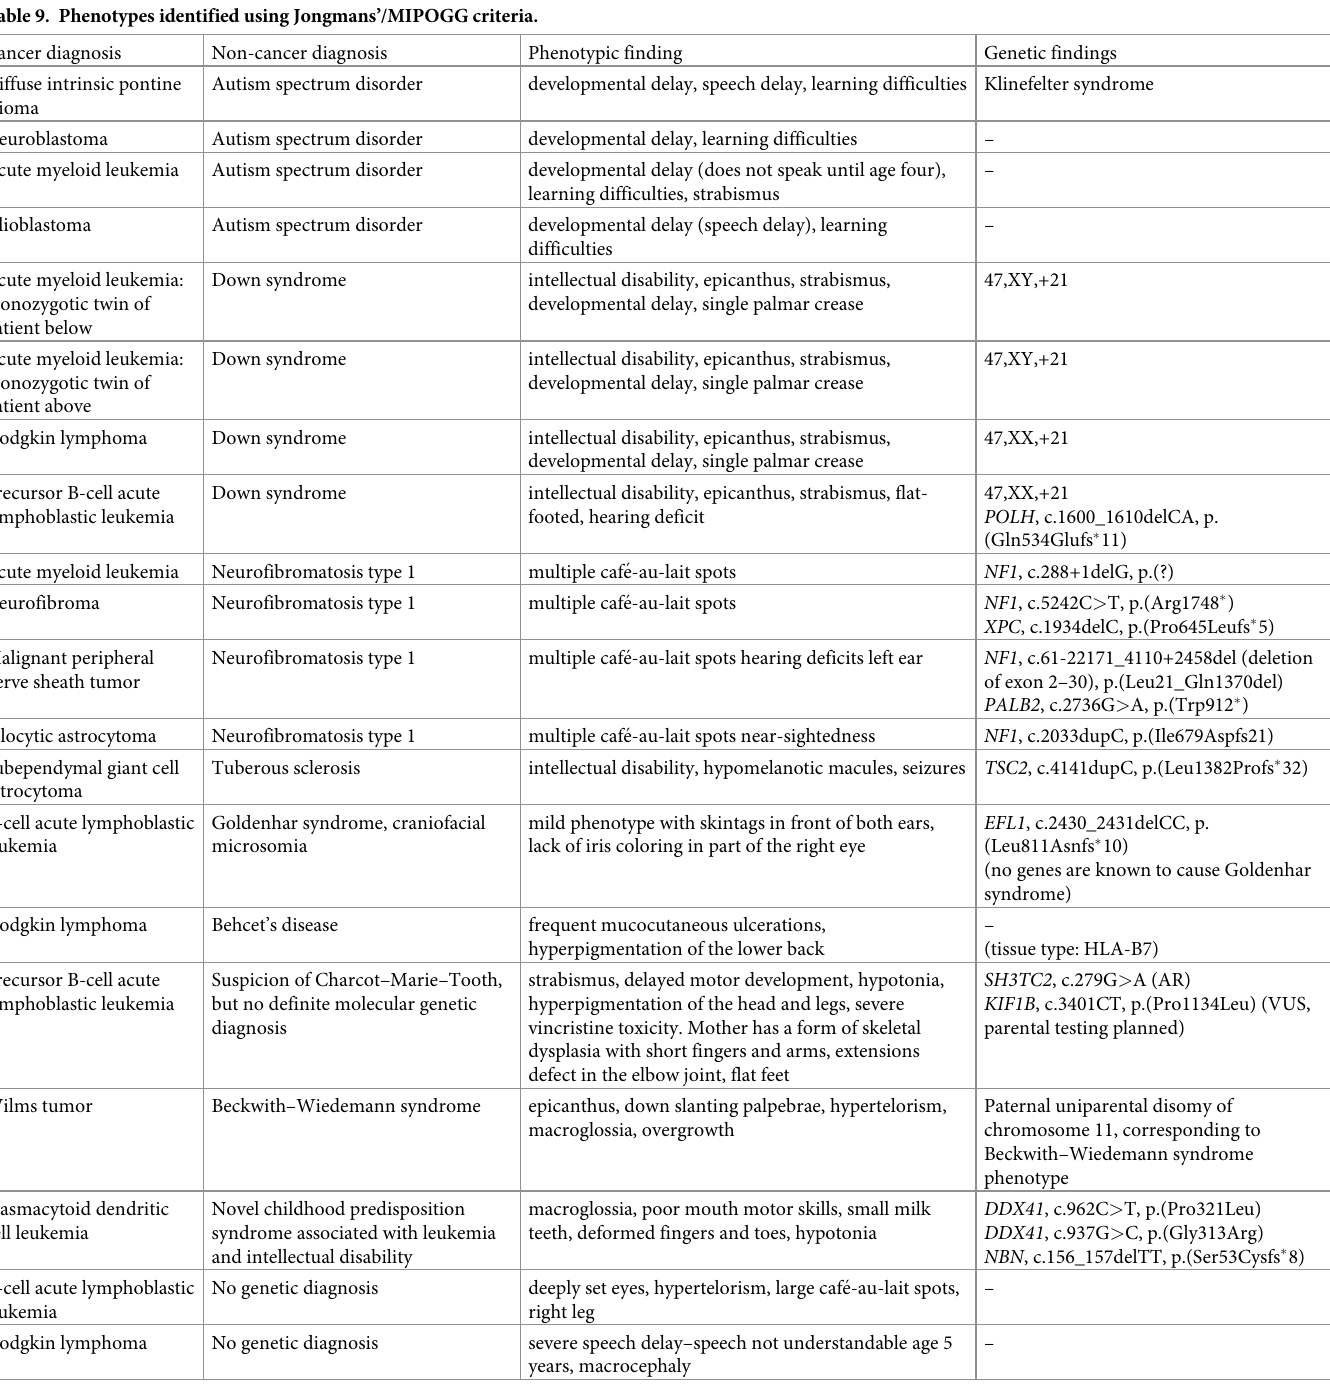
Table 9. Phenotypes identified using Jongmans’/MIPOGG